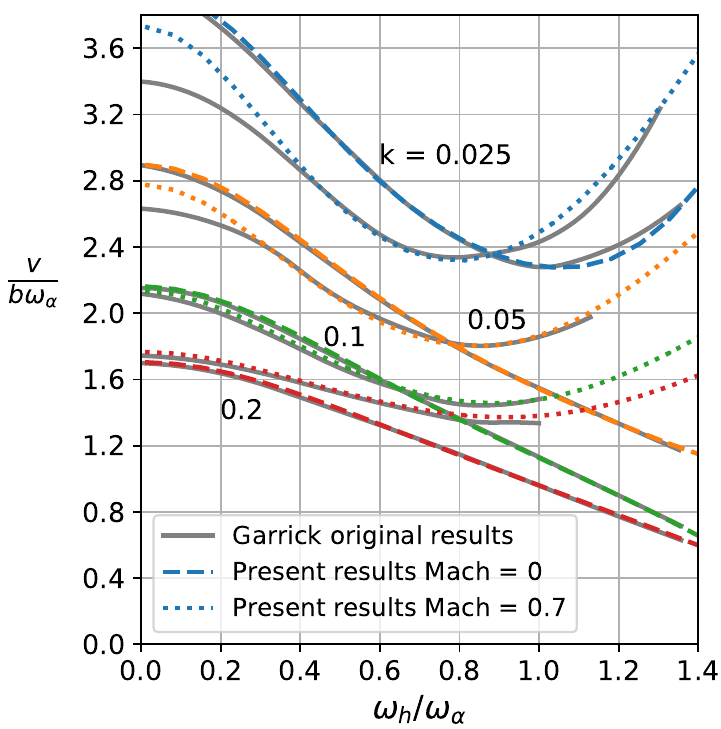
Figure 6. Flutter speed as a function of frequency ratio for an airfoil with elastic axis at midchord.